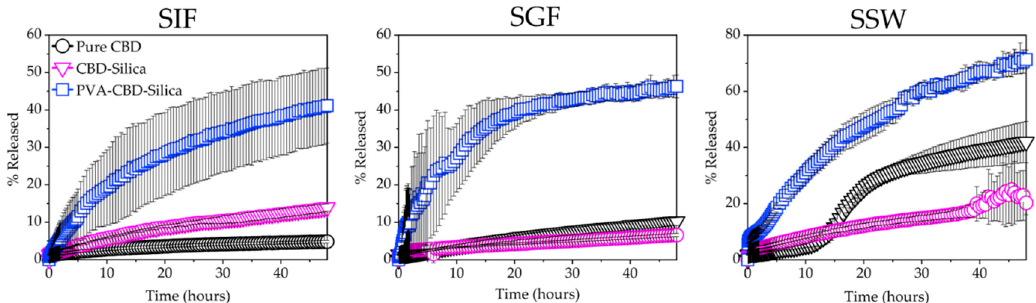
Figure 4. Dissolution profiles conducted at 30 °C in simulated intestine fluid (SIF, pH 6.8), simulated gastric fluid (SGF, pH 1.2) and simulated sweat (SSW, pH 6.6) under sink conditions for pure CBD, CBD-Silica and PVA-CBD-Silica film. Measurements are expressed as % release of total CBD in the formulation and were conducted in triplicates.